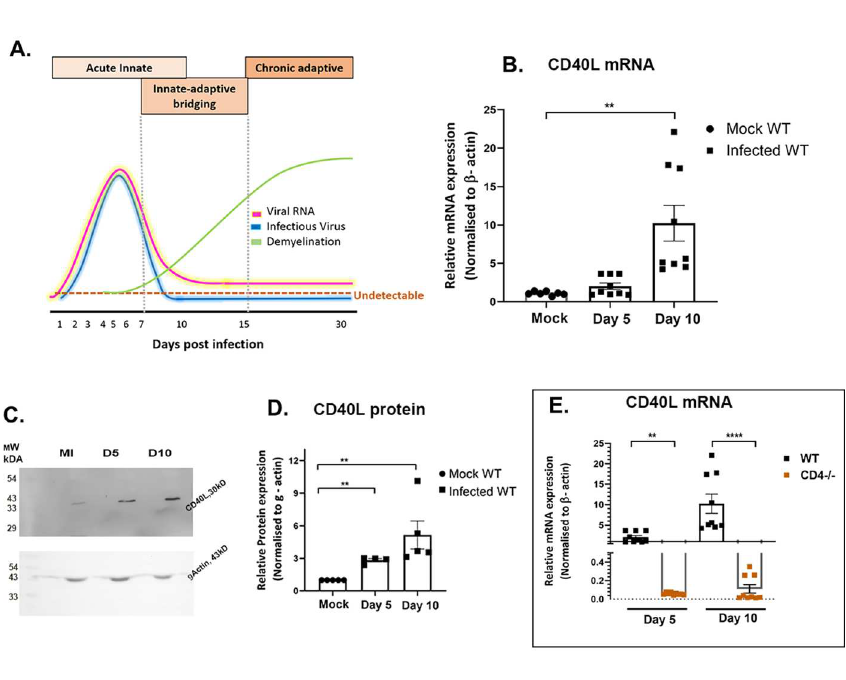
Fig 1. RSA59 infection alters the expression of CD40L in WT and CD4 -/- mouse brains. (A) Schematic diagram representing the kinetics of MHV-A59/RSA59 viral RNA, infectious particles, and phases of immune response correlating with acute phase neuroinflammation, the bridging of innate and adaptive immune responses, and chronic phase peak of demyelination following intracranial inoculation. Scale-arbitrary. (B) CD40L transcript abundance was determined in whole brain lysates from RSA59 infected (25000 PFUs) WT mice on days 5 and 10 p.i. by qRT-PCR. Results were normalized to β -Actin, compared with mock-infected control, and expressed as mean ± SEM. (C, D) CD40L protein expression was determined by immunoblot analysis in whole brain lysates of RSA59 infected WT mice on days 5 and 10 p.i. Results were normalized to γ -Actin, compared with mock-infected control, and expressed as mean ± SEM. (E) Whole brain lysates of RSA59 infected WT and CD4 -/- mice were subjected to qRT-PCR, and CD40L transcript abundance was compared between the two mouse strains on days 5 and 10 p.i. � Asterisk represents statistical significance calculated using unpaired Student’s t-test, p < 0.05 was considered significant. �� p < 0.01, ���� p < 0.0001. Data is represented from 3 independent biological experiments, N = 3.